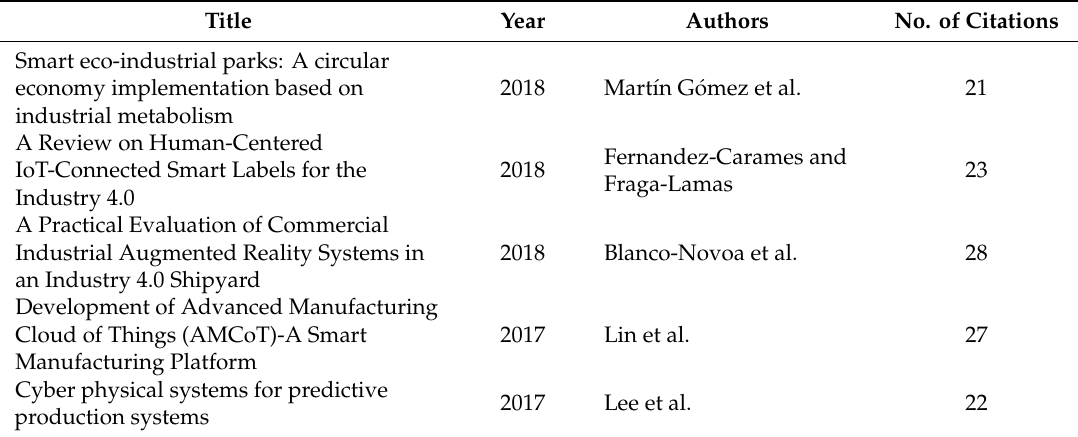
Table 3. The most cited documents (source: Scopus).